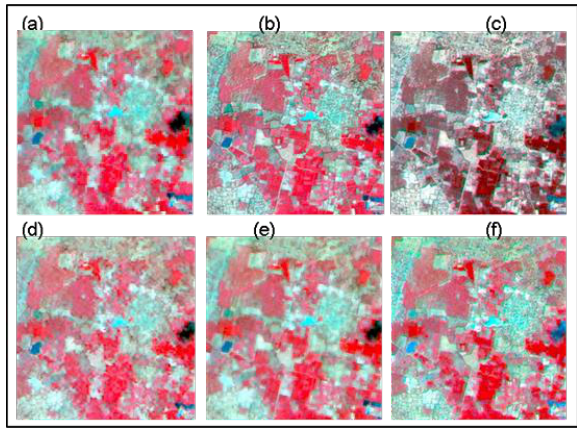
Fig-4: FCC images of (a) L-3 (b) L-4MX (c) Brovey d) IHS (e) HPF and (f) Wavelet